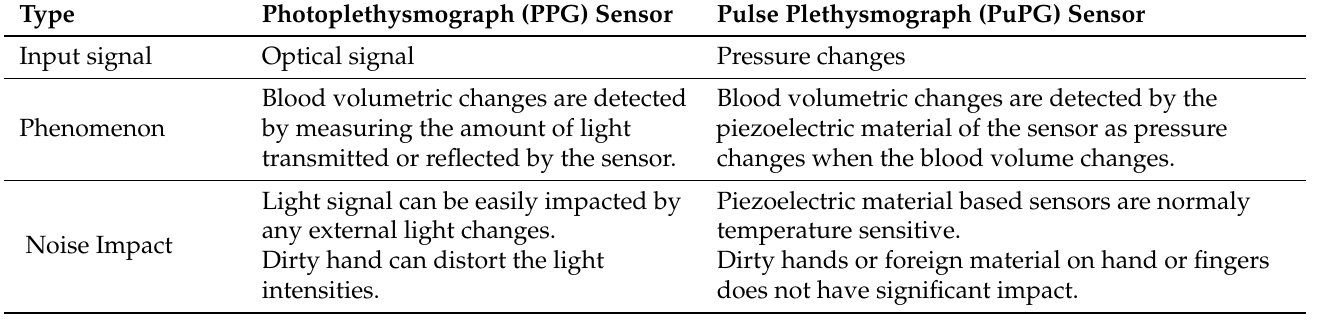
Table 2. Difference between PPG and PuPG data acquisition.